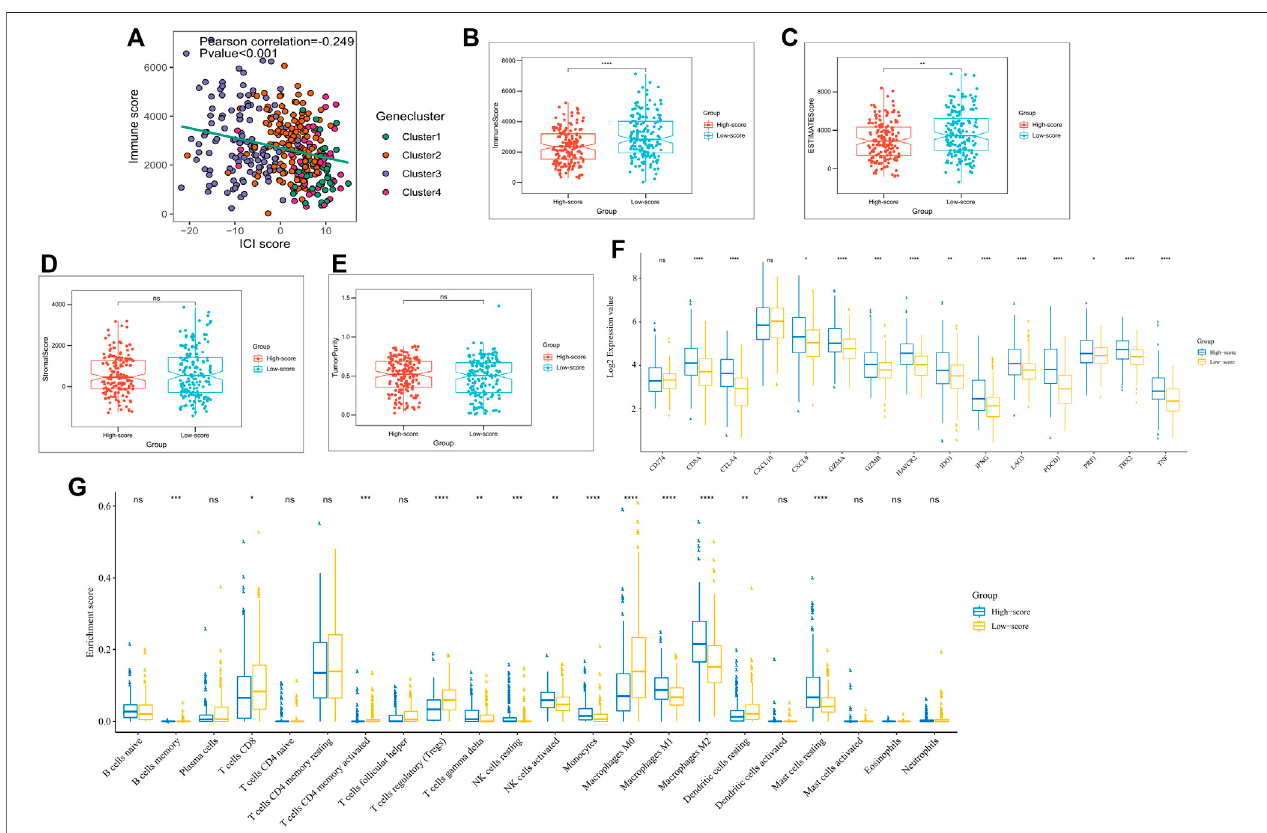
FIGURE 4 | Immune landscape of subgroups with different ICI scores. (A) Scatter plots depicting a negative correlation between ICI scores and immune scores in theTCGAcohort,showingaPearsoncorrelationbetweenICIscoresandimmunescores; (B) Expressionofimmunecheckpoint-relatedgenes(IDO1,CD274,HAVCR2, PDCD1, CTLA4, and LAG3) and immunoreactive-related genes (CD8A, CXCL10, CXCL9, GZMA, GZMB, PRF1, IFNG, TBX2, and TNF) in high and low ICI score subgroups; (C) ICIProportionindifferentICIscoresubgroups; (D) ImmunescoresofthehighandlowICIscoregroups; (E) ESTIMATEscoresofthehighandlowICI score groups; (F) Stromal scores in the high and low ICI score subgroups; (G) Tumor purity in the high and low ICI score subgroups. * p < 0.05; pp p < 0.01; pppp p < 0.001; pppp p <